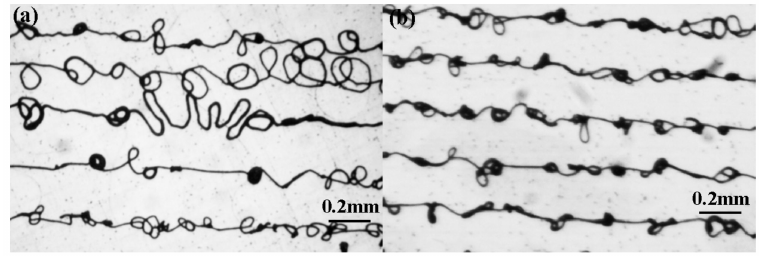
Figure 5. Direct-written parallel lines with assisted airflow of 25 kPa. ( a ) L = 0.5 mm; ( b ) L = 2 mm. The collector moving speed was 1